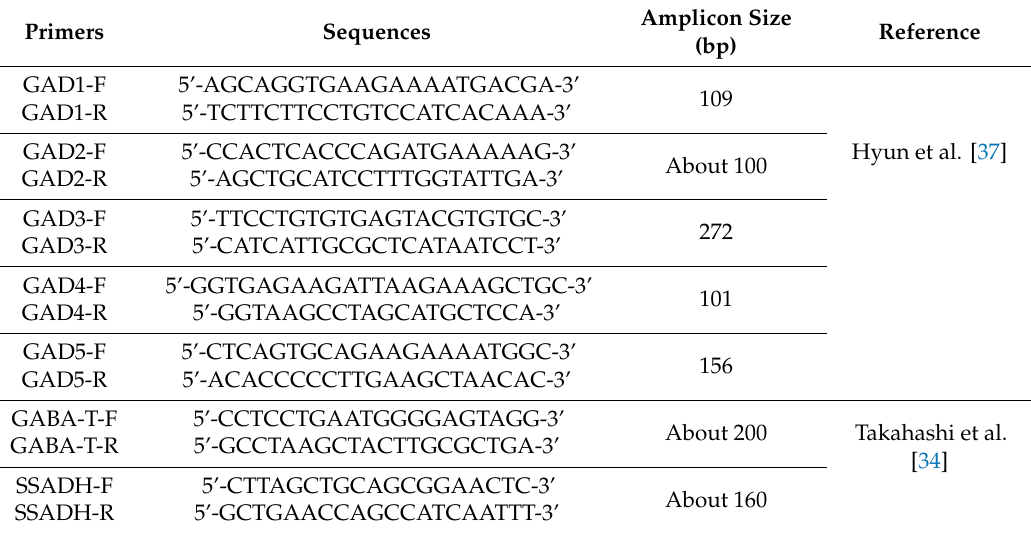
Table 1. Primer sequences of γ -aminobutyric acid (GABA)-related